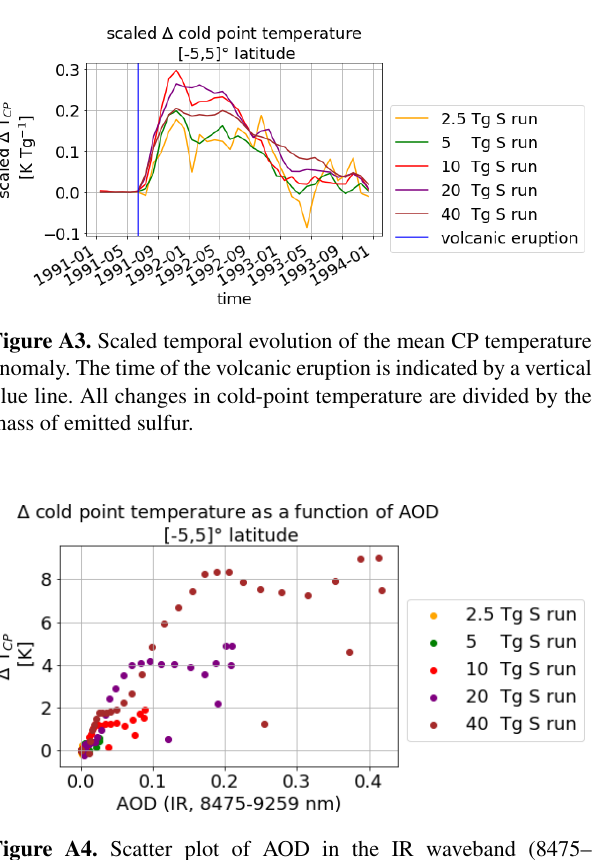
Figure A4. Scatter plot of AOD in the IR waveband (8475– 9250nm) and CP temperature anomaly for all time steps in the first 2.5 years after the